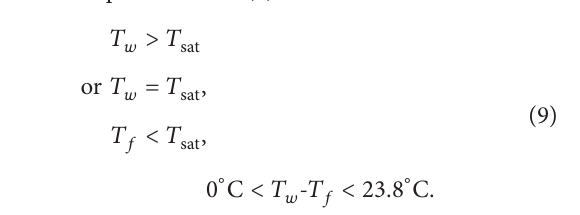
Units of vertical tube (experimental) Units of vertical tube (correlation calculated) Rohsenow correlation (saturated boiling) McAdams correlation (natural